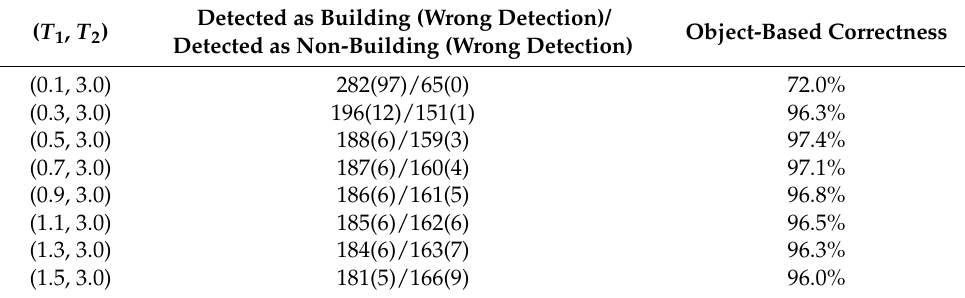
Table 6. Statistics of the object-based classification with different T 1 .